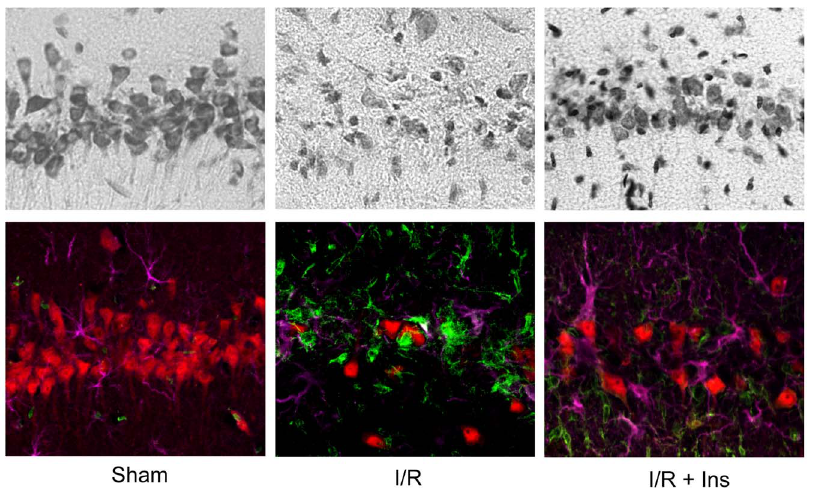
Figure 2. Insulin prevents neuronal cell death in the CA1 hippocampus following brain ischemia. Cresyl violet stained sections (top row) show CA1 hippocampus densely populated with pyramidal neurons in sham-operated controls (Sham), and triple-label immunofluorescence (bottom row) shows these cells to be NeuN-positive (red). After 8 min of global brain ischemia followed by 14 days of reperfusion (I/R, n=5) there is a 90% loss of CA1 neurons and an increase in Iba-1-positive microglia and GFAP-positive astrocytes (green and magenta, respectively). Animals exposed to 8 min of ischemia followed by 14 days of reperfusion with a single bolus of insulin given at the onset of reperfusion (I/R + Ins, n=4) demonstrate a 49% increase in NeuN-positive neurons (p , 0.05) while Iba-1 and GFAP-positive cells remain unchanged.